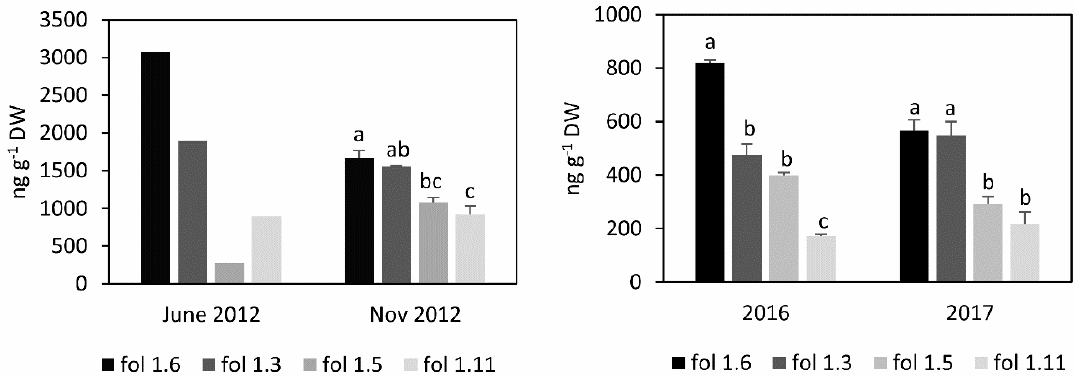
Figure 1. Folate concentrations of fol lines from four independent harvests. Data for June 2012 are means of two technical determinations on a pool of tubers from several clonal plants ( n = 1). Data for November 2012 are means ± SE of two technical determinations on each of two biological